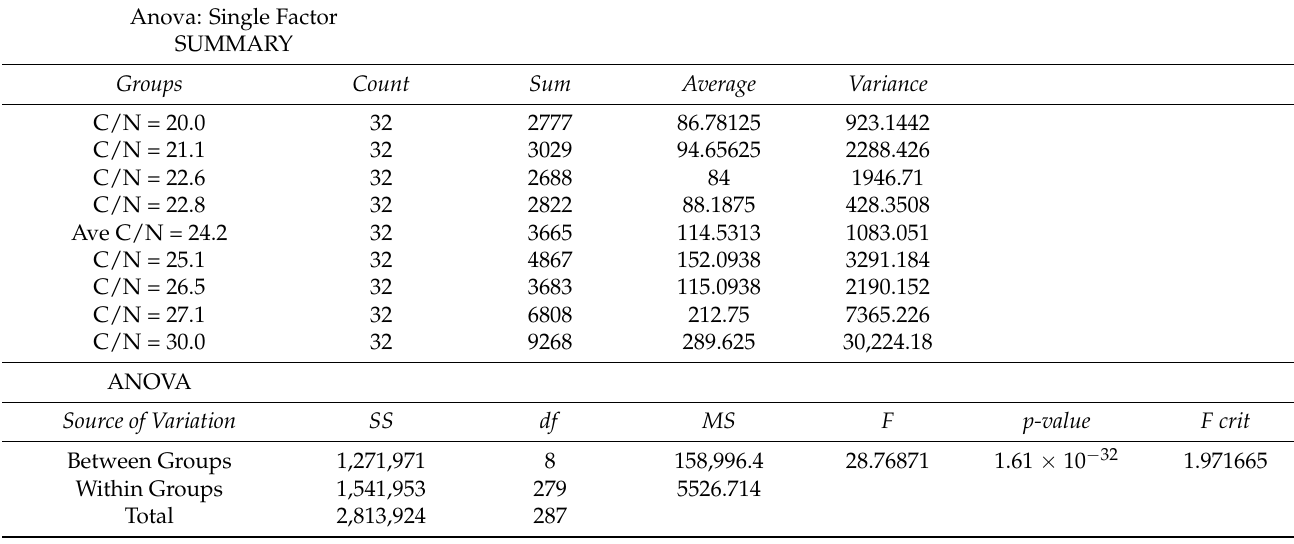
Table A4. One-way (ANOVA) test for daily biogas yield from all reactors.